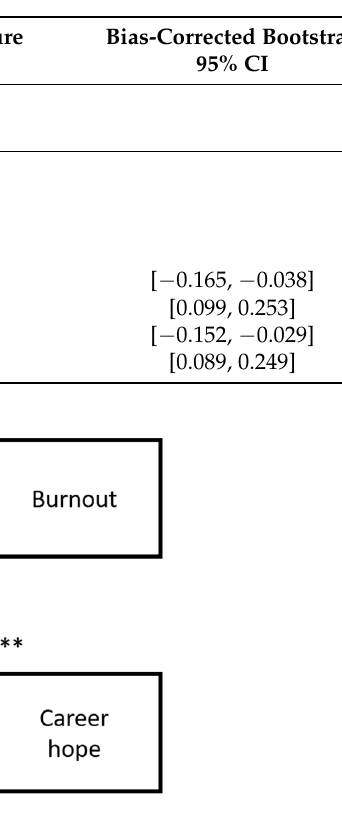
Table 3. Structure coefficient and mediation effect test.